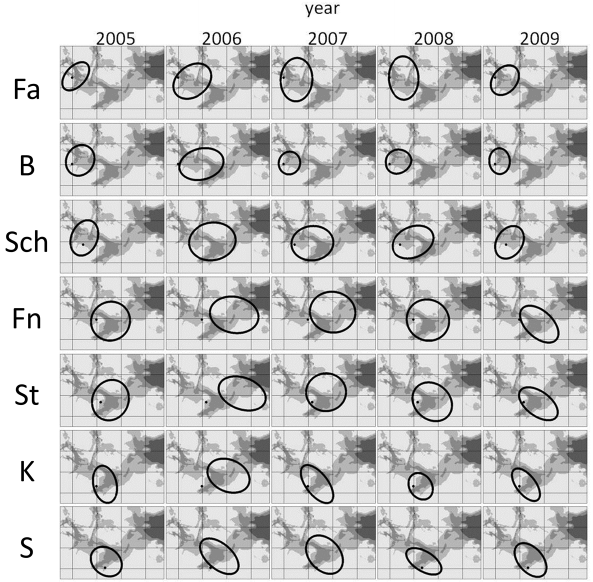
Fig. 3. Dispersal kernels describing the back-calculated origins of drifting particles released at the different platform locations (black dots), 1st to 7th Rows represent the locations FA = Falsh¨oft, B = Boknis Eck, Sch = Sch¨onberg, Fn = Fehmarn, St = Staberhuk, K = Kellenhusen, and S =